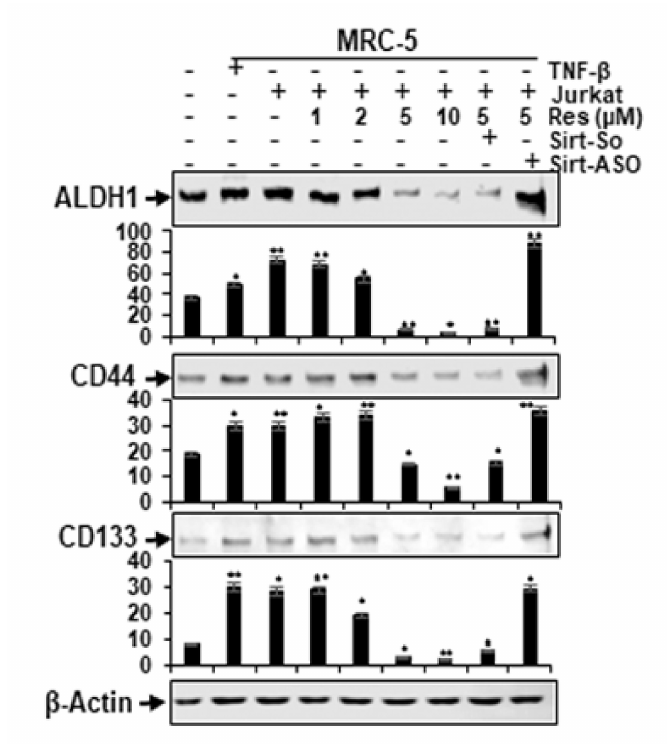
Figure 6. Impact of resveratrol and Sirt1-ASO on activation of cancer stem cells in the multicellular- TME. Serum-starved cultures of HCT116 cells in 3D alginate cultures alone (basal control = co) or co-cultured with fibroblasts and TNF- β (10 ng / mL) (TNF- β -TME) or co-cultured with fibroblasts and T-lymphocytes (pro-inflammatory multicellular-TME) were either left untreated, or multicellular-TME cultures were treated with various doses of resveratrol (1, 2, 5, 10 µ M), or transfected with 0.5 µ M sense oligonucleotide (SO) control, or antisense oligonucleotides (ASO) against Sirt1 in the presence of Lipofectin transfection reagent (10 µ L / mL) and co-treated with resveratrol (5 µ M) for 14 days in alginate cultures, as described in Material and Methods. Whole cell lysates were prepared and analyzed using Western blotting with antibodies against CD133, CD44 and ALDH1 in HCT116 cells. β -actin served as an internal loading control in all experiments. * p < 0.05, ** p < 0.01 relative to basal